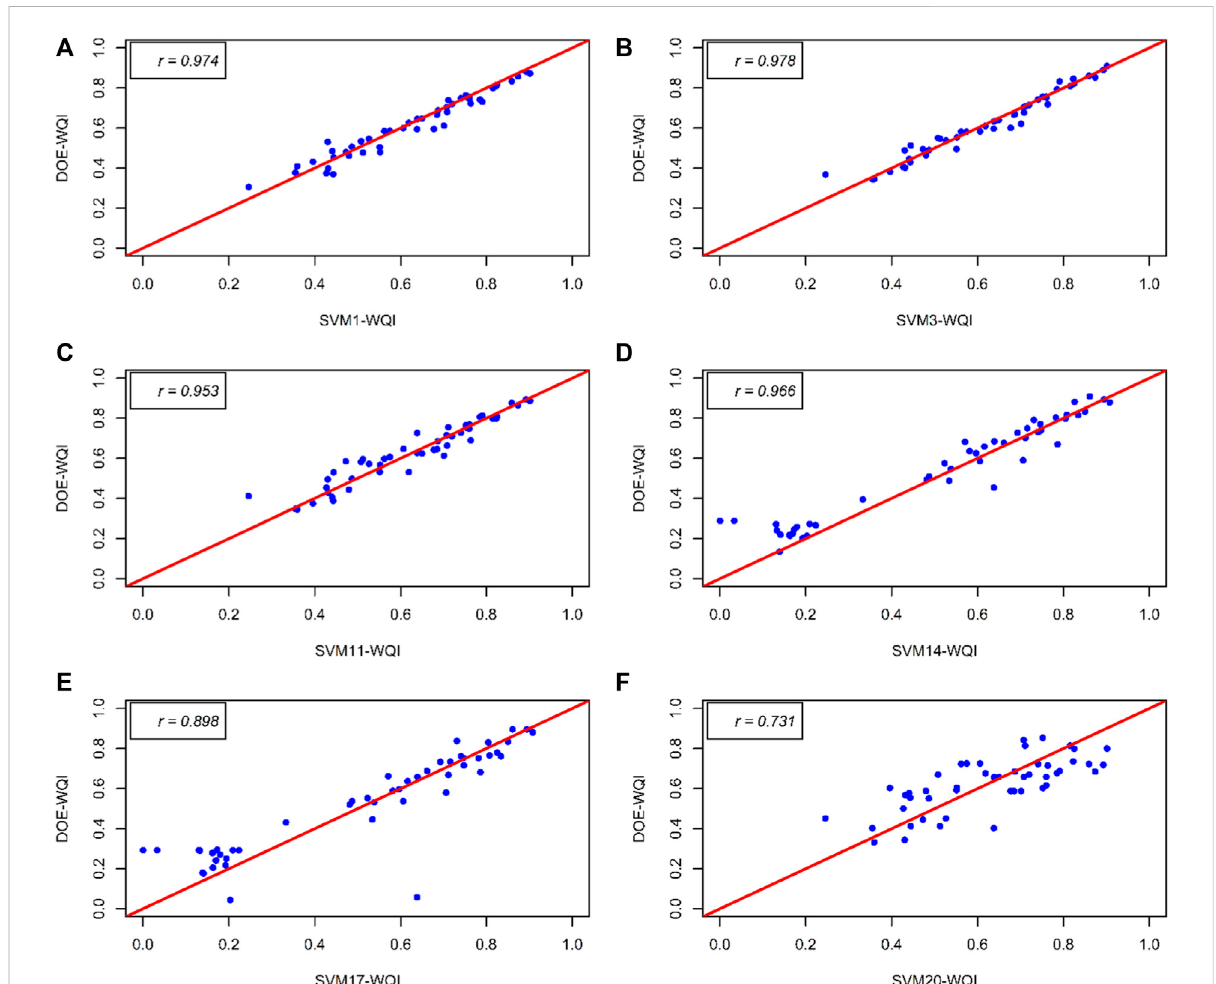
FIGURE 4 Correlation between the observed (DOE-WQI) and the best predicted model (SVM-WQI) for each scenario: (A) SVM1-WQI; (B) SVM3-WQI; (C) SVM11-WQI; (D) SVM14-WQI; (E) SVM17-WQI; and (F) SVM20-WQI.